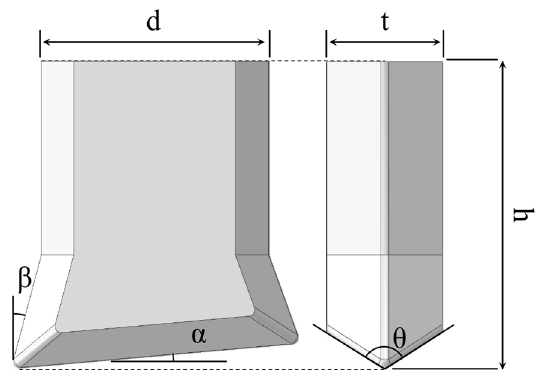
Figure 3. Basic shape of a cutting tool. Table 1. Names and specifications of the cutting tools.